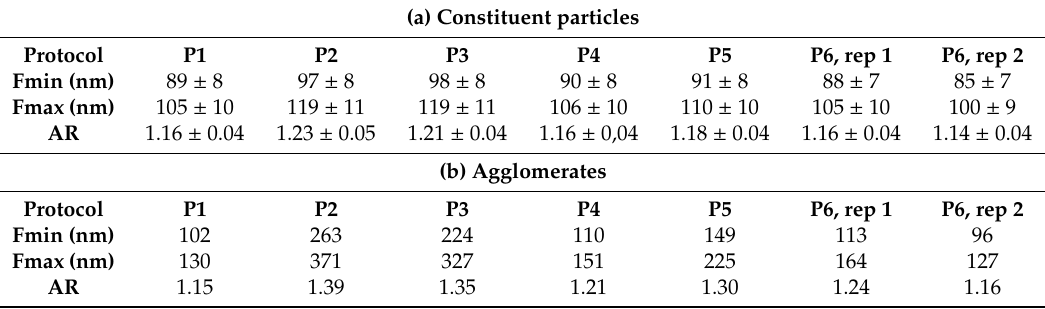
Table 5. Evaluation of sample preparation protocols based on the medians of the Fmin, Fmax, and aspect ratio (AR) distributions for ( a ) constituent particles and ( b ) agglomerates of anatase E171 material E171-06. For the constituent particles, expanded measurement uncertainties (Ucx, k = 2) are estimated based on the validation study of Verleysen et al. [59] for representative test material